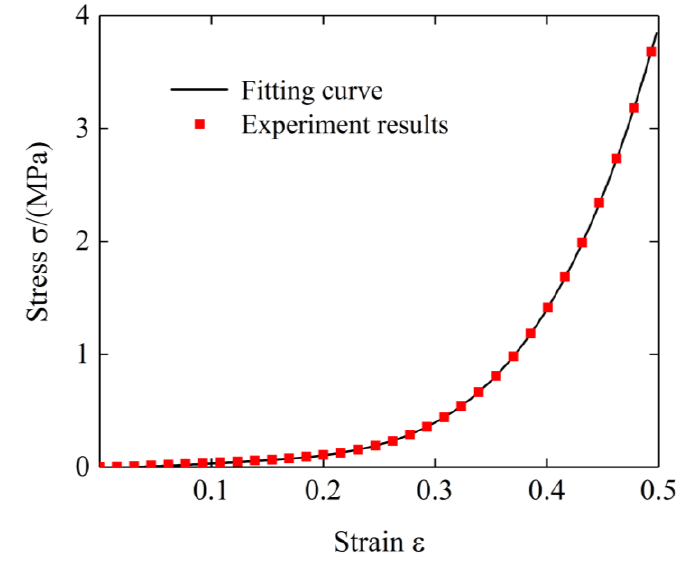
Figure 12. The stress-strain curves and its fitting curves ( ρ 0 = 1.905 g / cm 3 , T 0 = 20 ℃ ) Table 2. Fitting parameters of shape function.